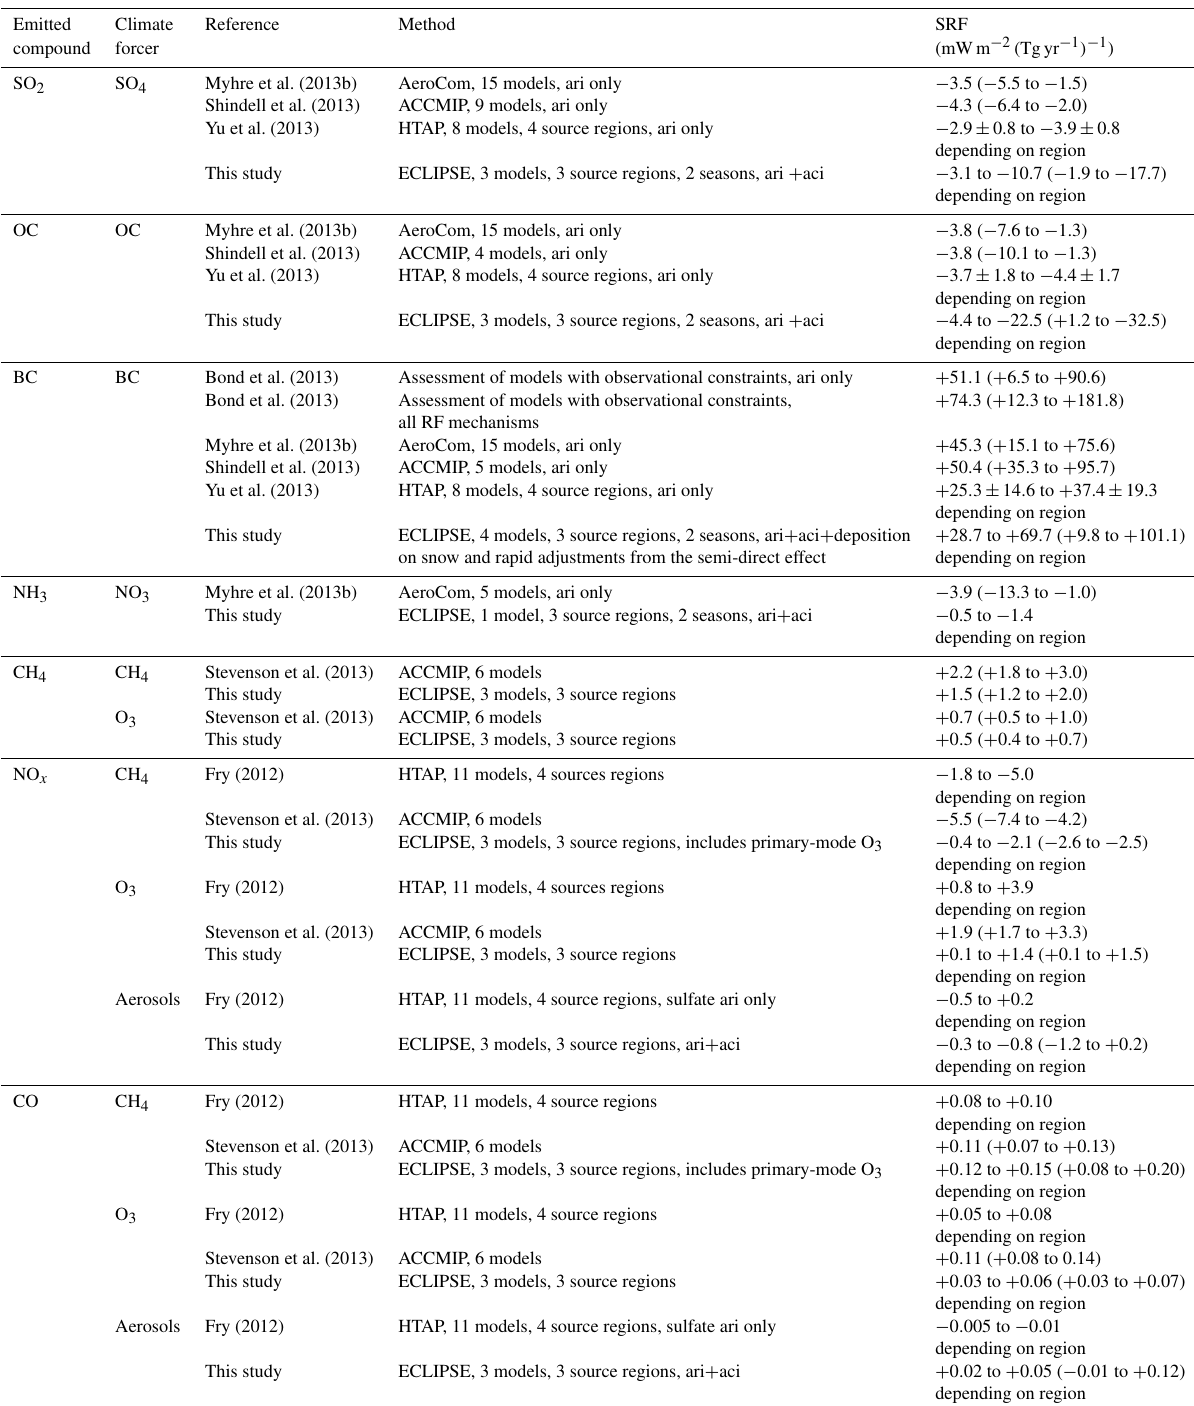
Table 1. Specific radiative forcing (SRF), in mWm − 2 (Tgyr − 1 ) − 1 , of near-term climate forcers, as estimated by scientific assessments and multi-model intercomparisons. Numbers shown are median and full range for all studies, except for Bond et al. (2013), in which best estimate and 90% confidence range are given; Yu et al. (2013), in which mean and standard deviation are given; Fry (2012), in which only the best estimate is available; this study, in which average and full range are given. Black carbon (BC) and organic carbon (OC) aerosols are for fossil-fuel and biofuel sources only, except for Bond et al. (2013), in which also biomass-burning sources are included. For aerosols, the radiative forcing is for aerosol–radiation interactions (ari) only, except for the estimate by Bond et al. (2013) denoted “All”, which also includes aerosol–cloud and aerosol–surface interactions, and for estimates by this study, which also include aerosol–cloud interactions